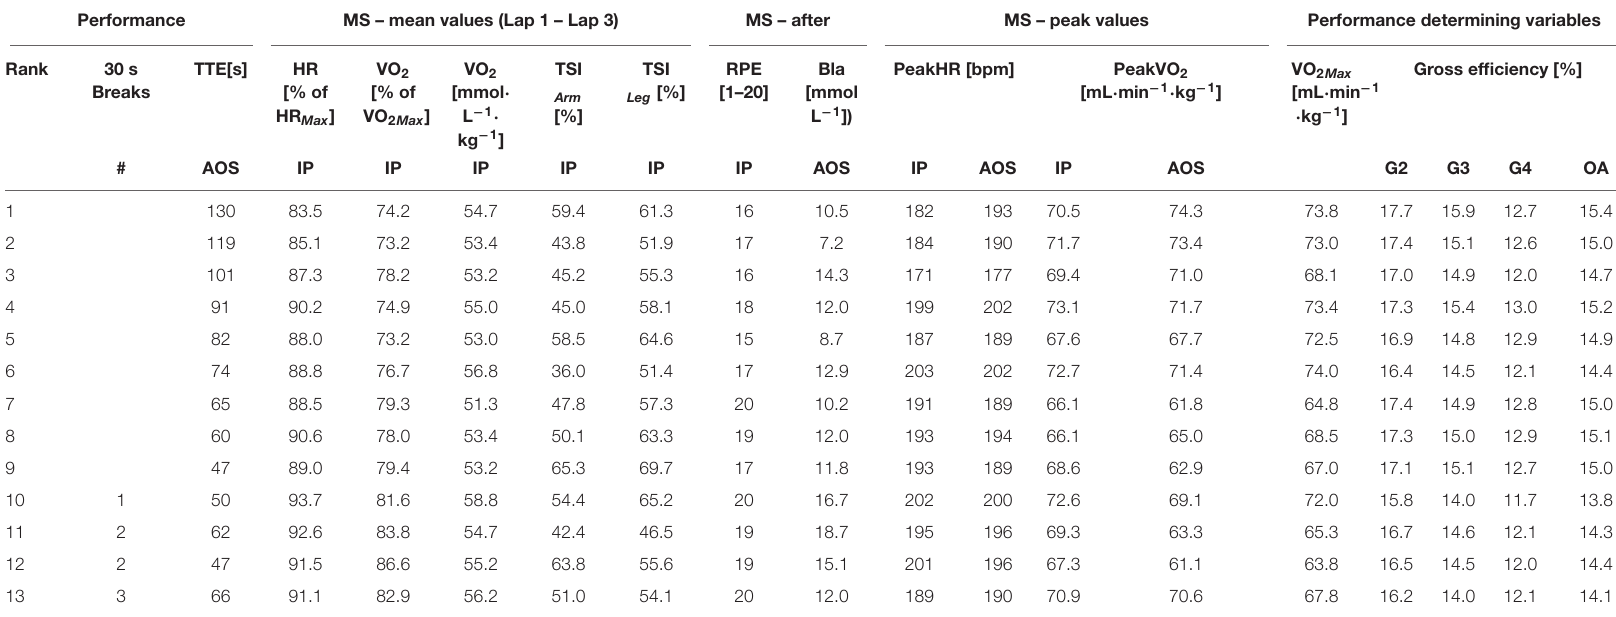
Values collected during the simulated mass-start are shown either for the initial part (IP) or after the all-out sprint (AOS). Rank, ranking in the simulated mass-start; TTE, time to exhaustion; HR, heart rate; HR Max , the highest measured heart rate; VO 2 , oxygen uptake; VO 2Max , The highest 30-s moving average (based on 10 s mixing chamber values) during the incremental maximum test; TSI Leg , tissue saturation index for the vastus lateralis of the right leg; TSI Arm , tissue saturation index for the long head of the triceps brachii on the right arm; RPE, rate of perceived exhaustion; BLa, blood lactate concentration; and Peak HR/VO 2 , the highest measured HR/VO 2 during the specified